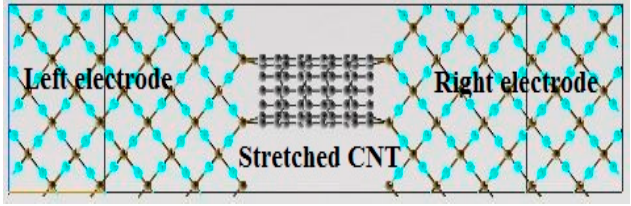
Figure 2. Two ‐ probe geometry in which stretched CNT is sandwiched between CrO 2 electrodes.